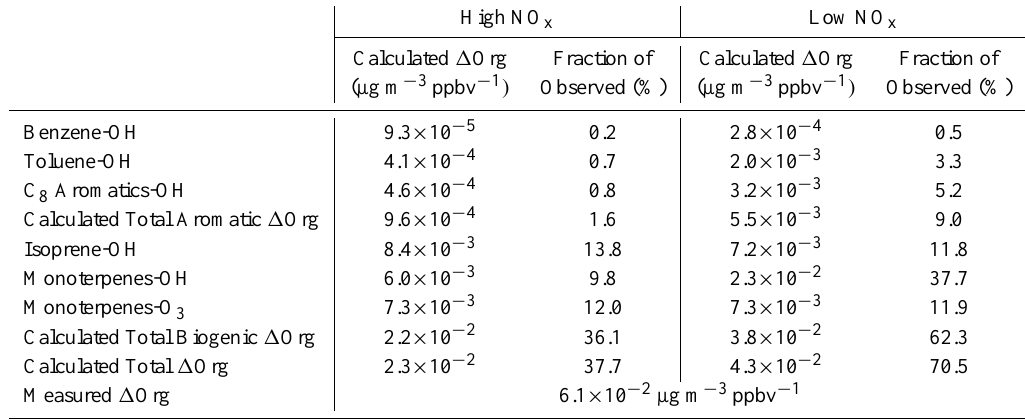
Table 1. Calculated Contributions to Secondary Organic Aerosol Formation for the Full Campaign (all normalized to CO).